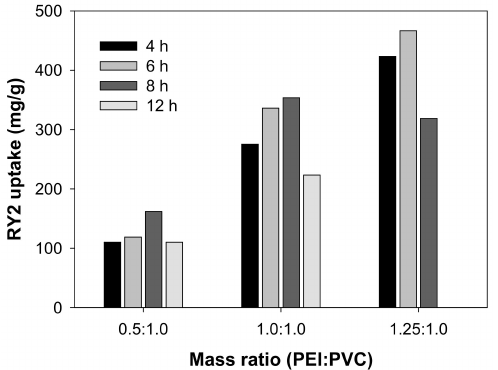
Figure 1. Comparison of Reactive Yellow 2 (RY2) uptake on polyethylenimine/polyvinyl chloride cross-linked fiber (PEI/PVC-CF) prepared under different conditions (Mass ratio (PEI:PVC) = 0.5:1.0, 1.0:1.0, and 1.25:1.0; cross-linking time = 4, 6, 8, and 12 h; adsorption conditions = C i 500 mg/L, pH 2.0, 24 h, and 25 ◦ C).